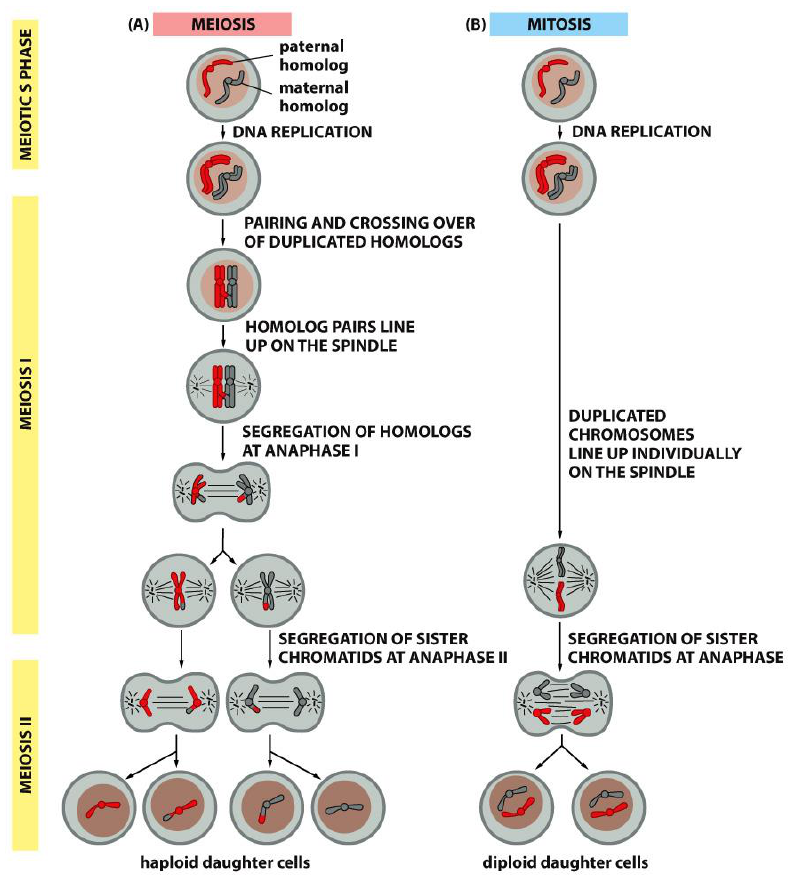
Figure 17. Diagrams of meiotic ( A ) and mitotic ( B ) cell divisions. With permission from the Taylor Francis Group, publishers.